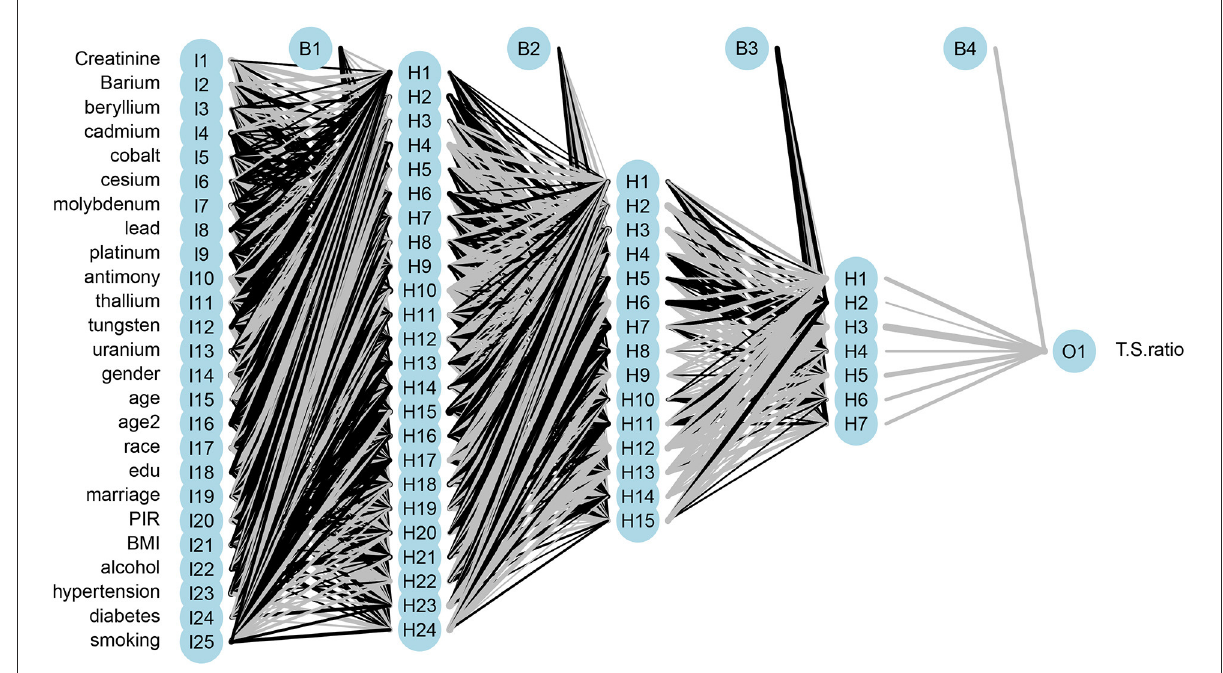
FIGURE2 Architecture of multilayer artificial neural network of urinary metal for LTL prediction.